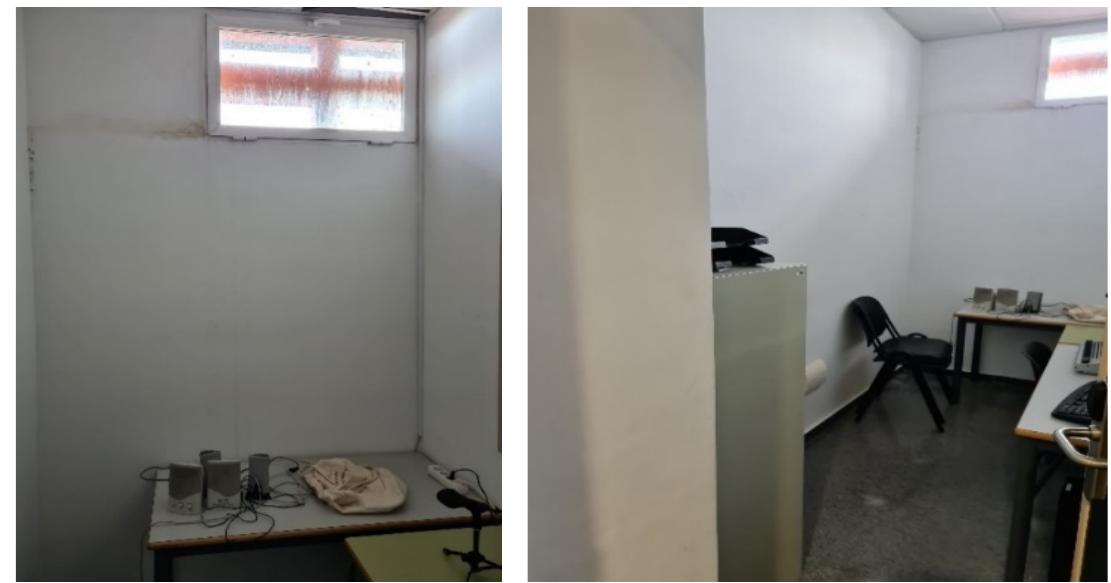
Figure 12. The initial state of the control room.